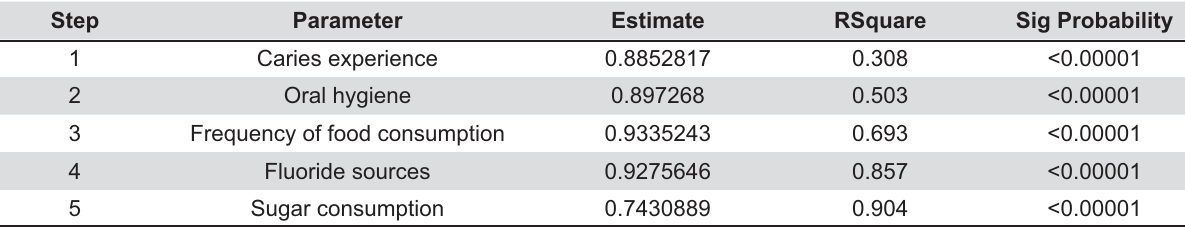
Table 4- Order of inclusion: the variables in a forward stepwise multiple regression model